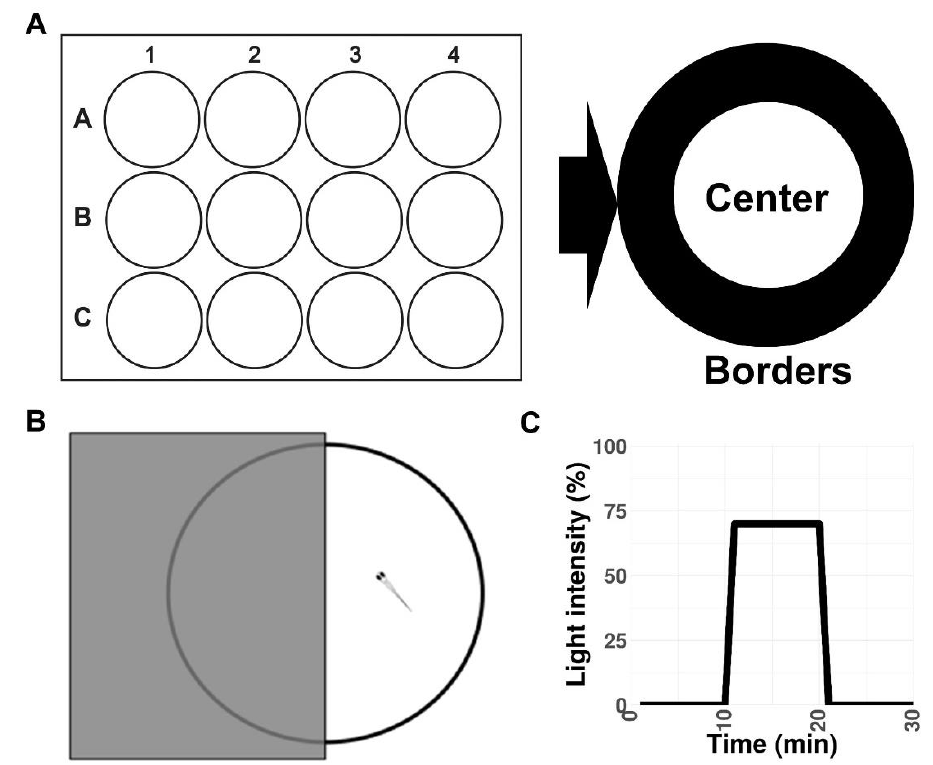
Figure 3. Schematic representations of the experimental setup. ( A ) Open field test in a 12-well plate.